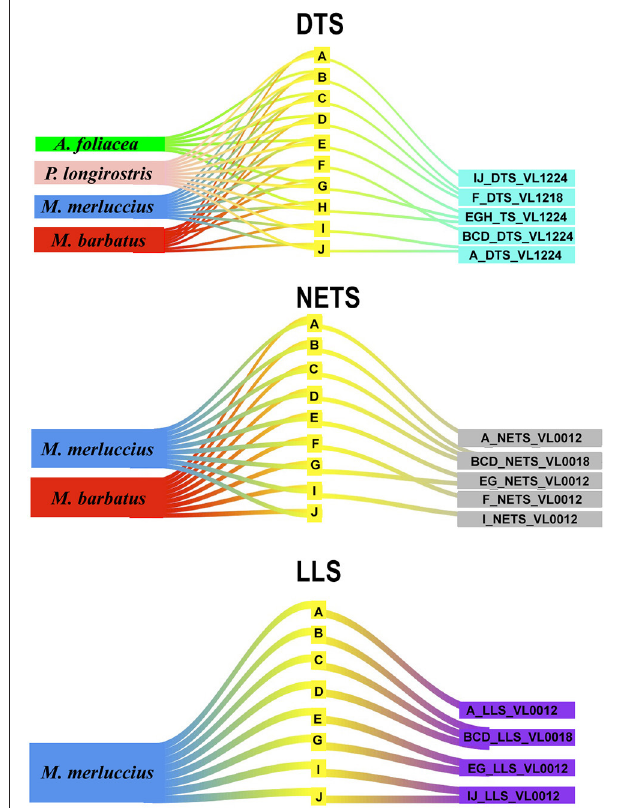
FIGURE 2 | Sankey plots (Weiner, 2015) representing the relationship between species distributions in the different fishing grounds and effort activity/target species for the different fleet segments. DTS stands for bottom otter trawl, NETS stands for gill net and trammel nets, LLS stands for longliners, the fishing grounds of activities are coded from A to J. VL stands for vessel length. The fleet segment codification is built as a concatenation of fishing ground, gear, and vessel length